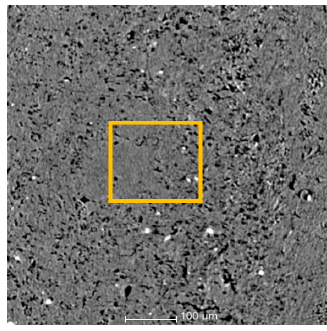
Figure 4. Component distribution.